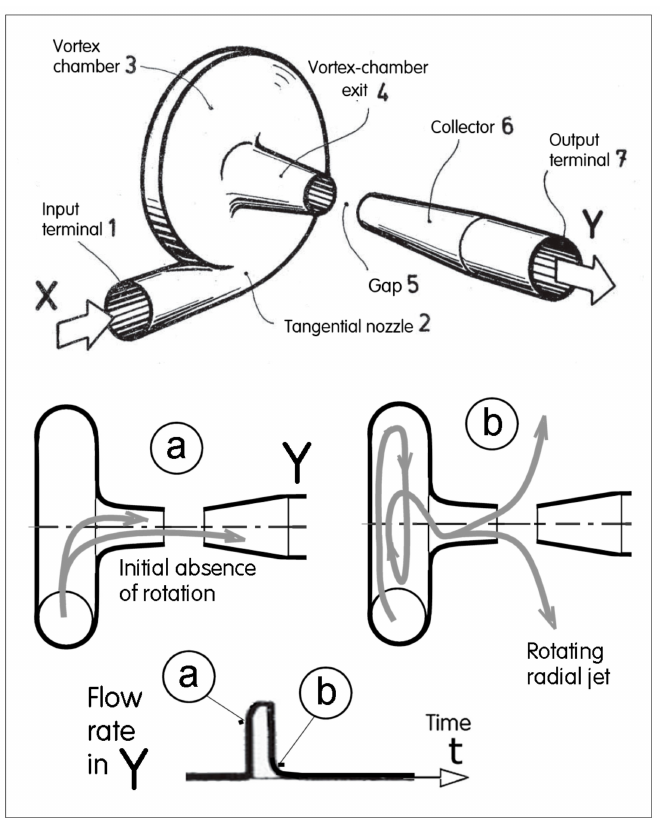
Figure 22. Pulse shaper [26] based on the vortex spin-up delay as shown in Figure 22. ( a ) Initially the inertia of non-rotating input flow jet carries it from the vortex chamber to the output terminal Y across the gap. ( b ) In the full rotation, the centrifugal force causes the fluid to escape radially such that the output flow in Y is zero.